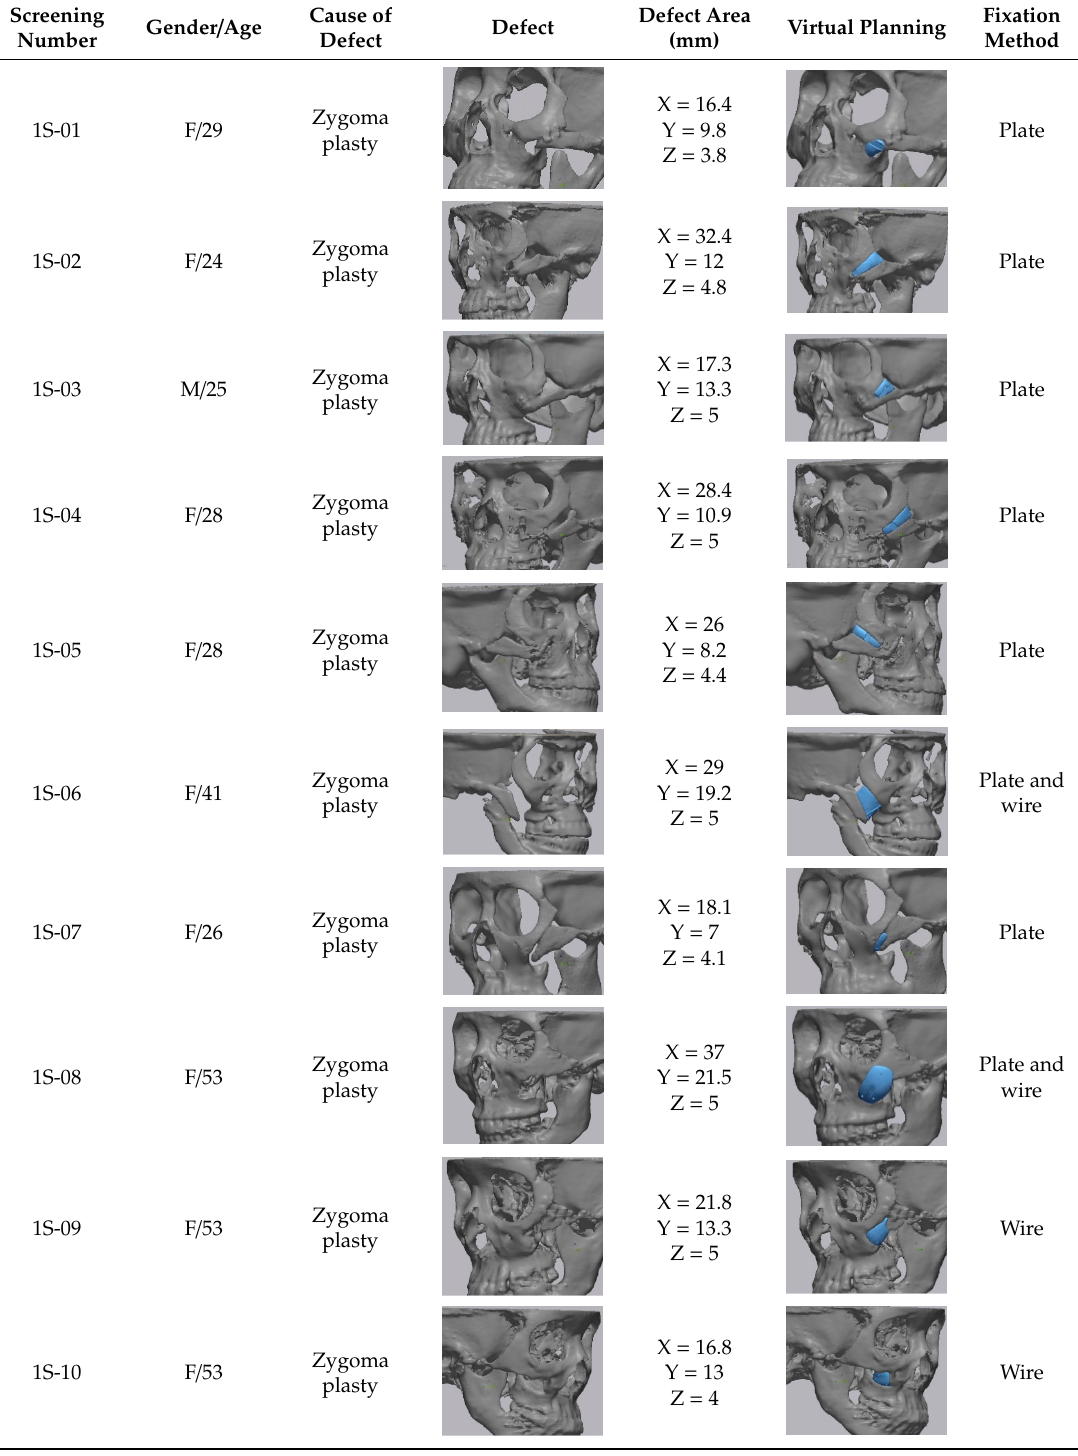
Table 2. Summary of demographic characteristics, zygoma defect configuration, and virtual design of a patient-specific implants.